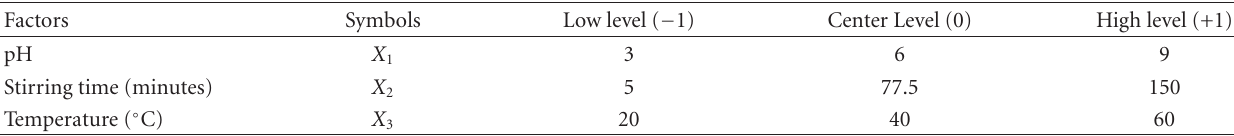
Table 6: The levels of experimental factors for the Box-Behnken experimental